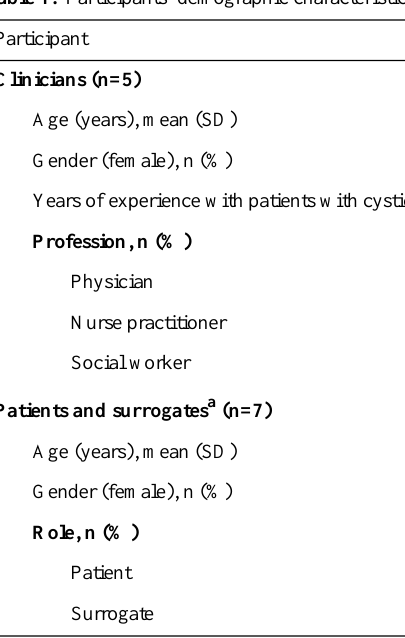
Table 1. Participants’demographic